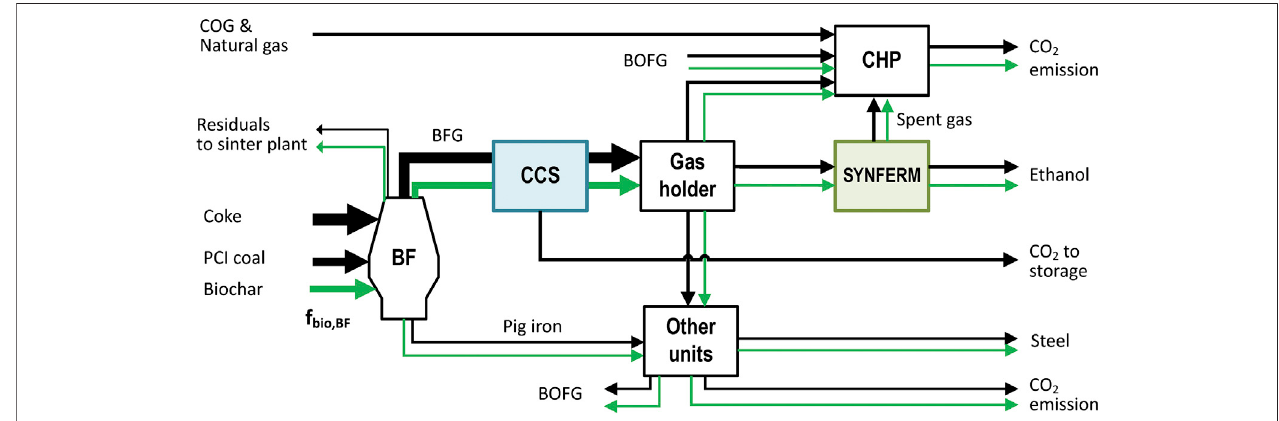
FIGURE 6 | Carbon fl ow pathways downstream of the blast furnace (CAS) when injecting biochar. The green arrows indicate the possible allocation/attribution of biogenic carbon to the respective process stream. The black arrows represent fossil carbon. Other units comprise steel mill units in the CAS, hot stoves, basic oxygen furnaces, gas fl aring, ladle, and rolling and